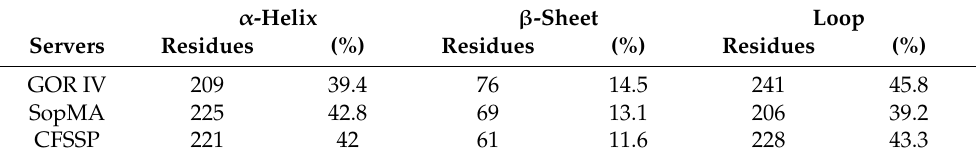
Table 2. Prediction of the secondary structure of MaBgl3 using GOR IV, SopMA, and CFSSP. α -Helix β -Sheet